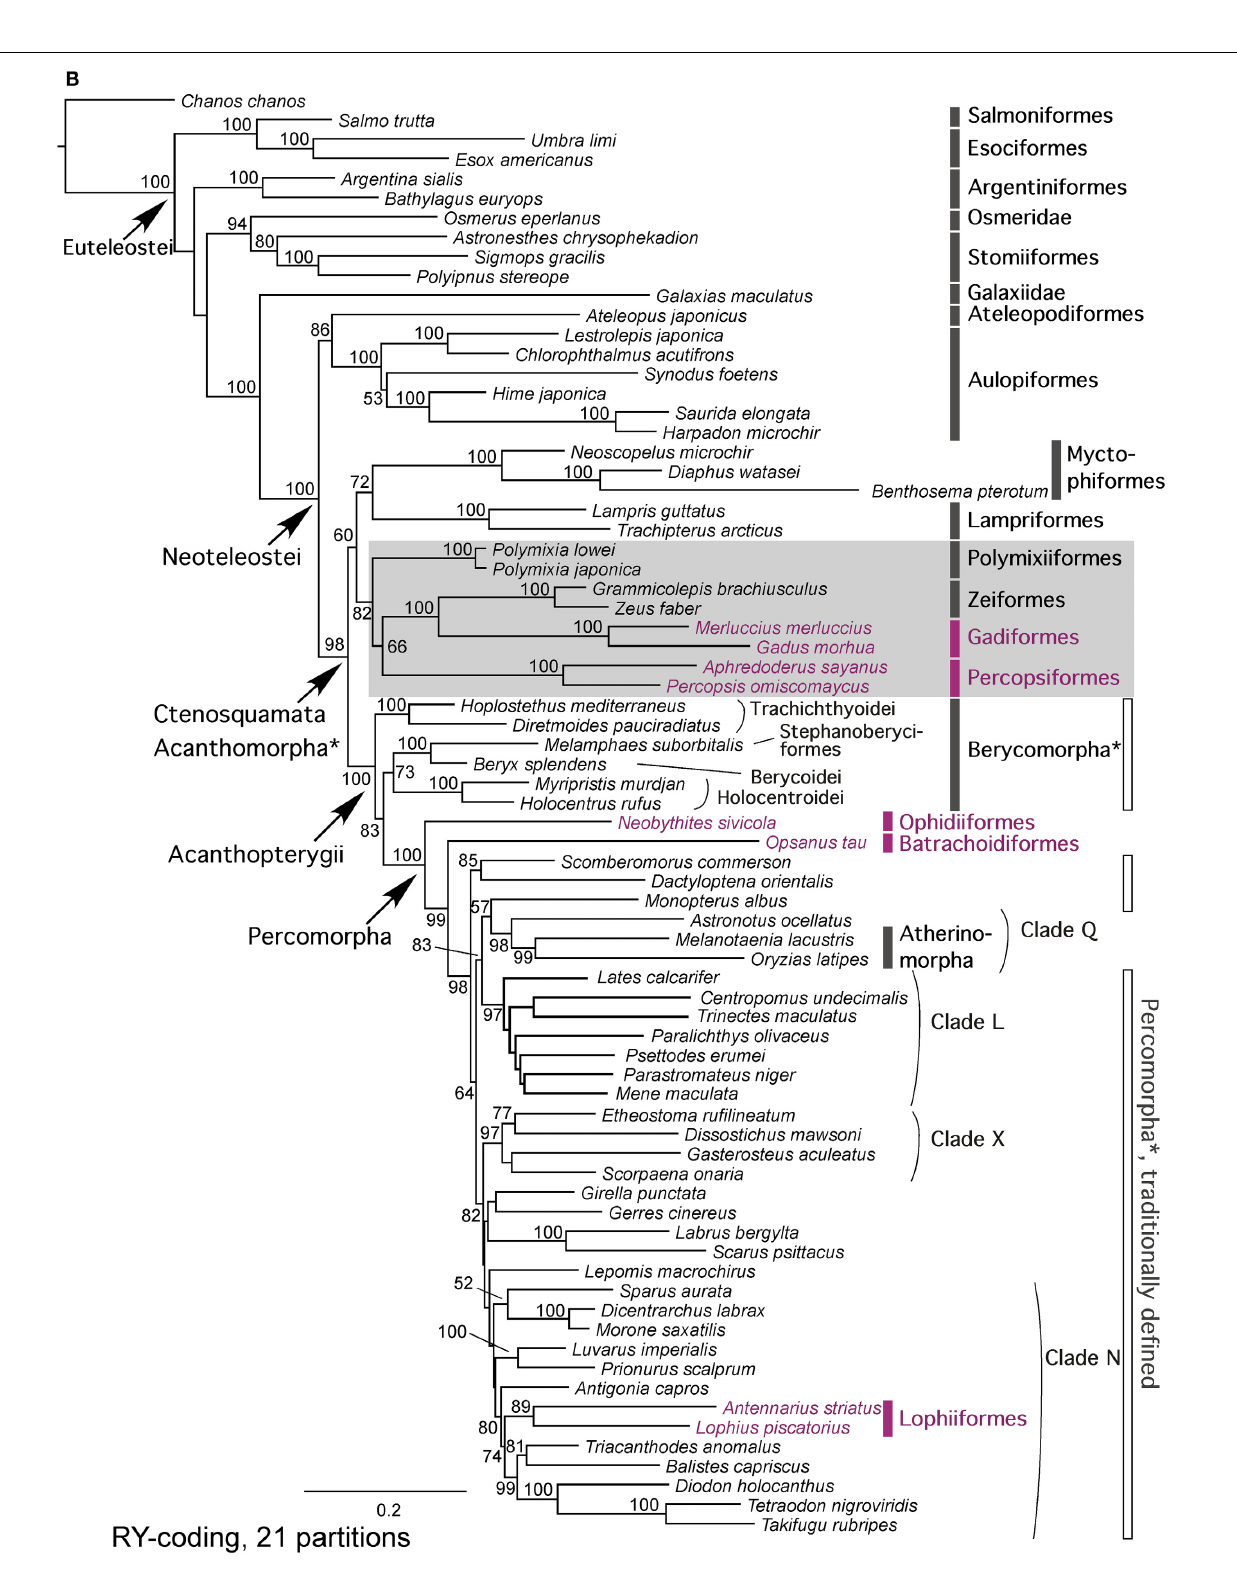
genes based on no weighting (A) and RY coding (B) data matrices that were partitioned by gene and codon positions (21 partitions) under a GTR + G model of nucleotide evolution. Their ML score is − 137523.0340 and 88770.9708,